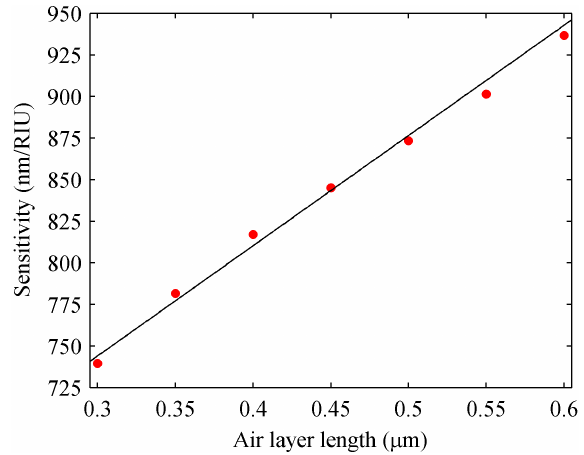
Figure 9. Transmission and spectral position of the cavity mode for different gases, with d Si = 0 . 14µm, d Air = 0 . 55µm, and d cavity = 0 . 645µm. The mode has a very broad bandwidth, yielding a sensor with poor resolution.